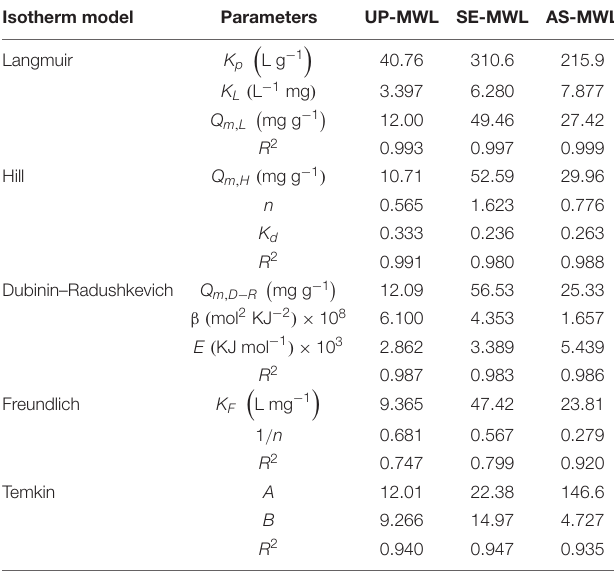
TABLE 3 | Parameters from different adsorption isotherm models. Isotherm model Parameters UP-MWL SE-MWL